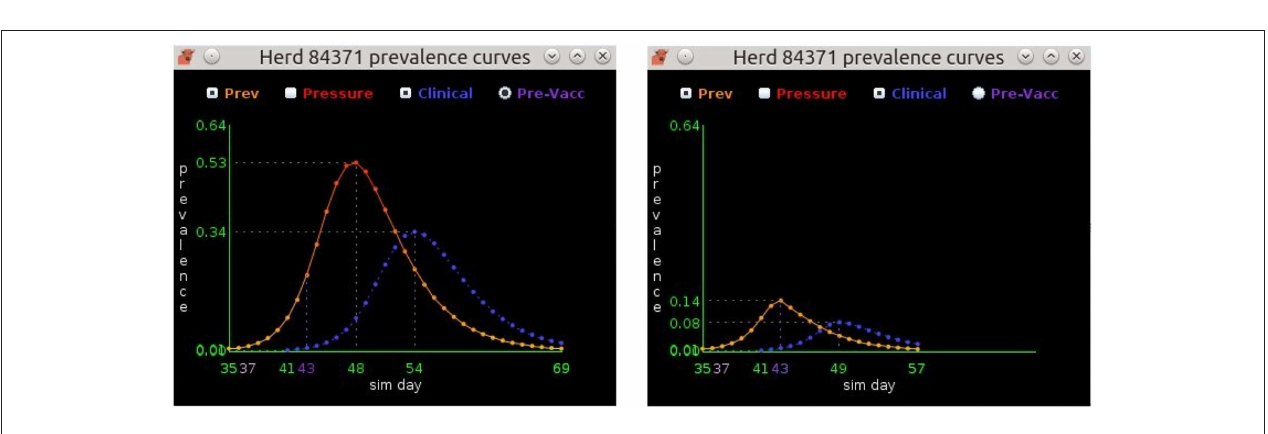
FIGURE 3 | The prevalence curves on the left depict the EBM solution for a non-vaccinated beef herd. Infection starts on day 35, peaks at 53% prevalence on day 48, and ends on day 69. The prevalence curves on the right show the same